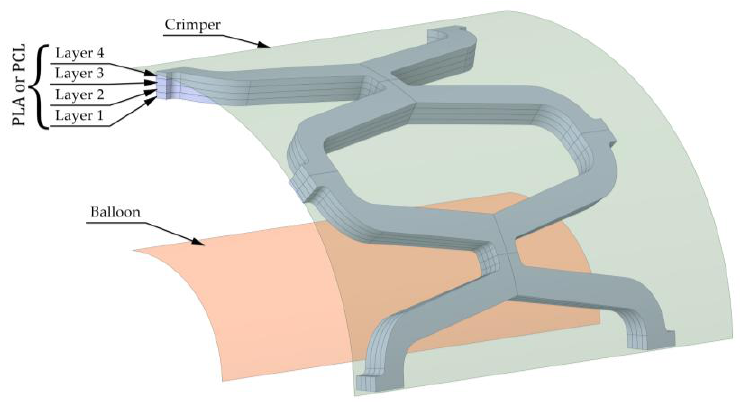
Figure 2. Stent geometry for numerical analysis with balloon and crimper. Table 2. Mechanical properties for materials considered in this study, adapted from